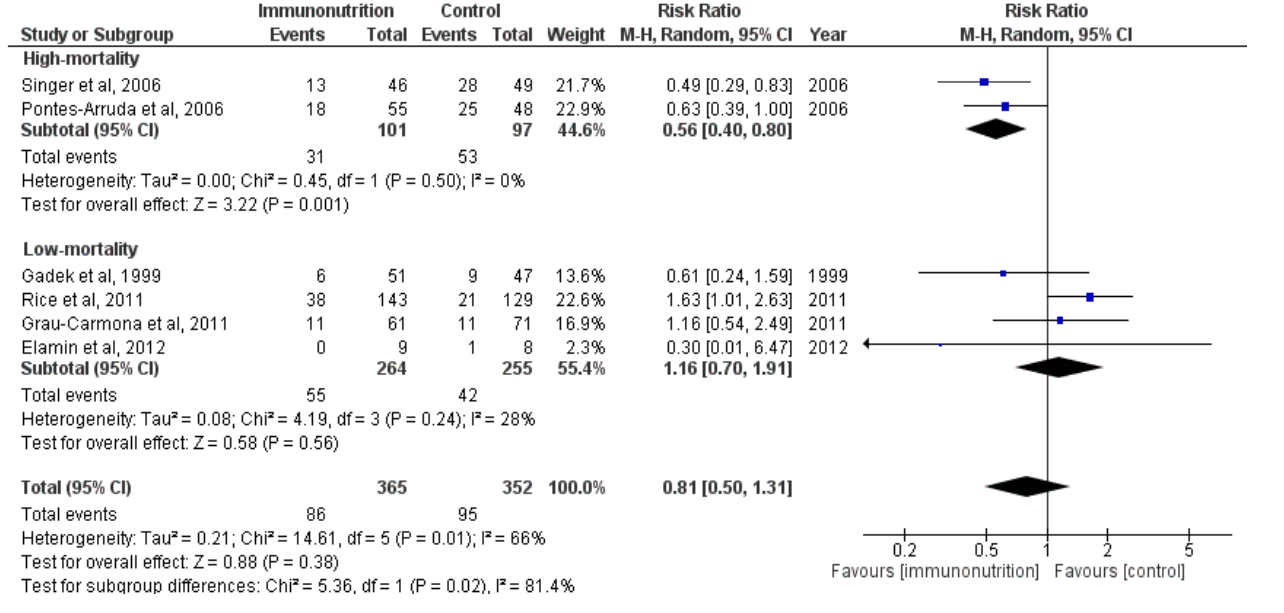
Figure 3. Forest plot of the association between enteral immunomodulatory diet and all-cause mortality among patients with ALI/ARDS, stratified by discrepancy of mortality.